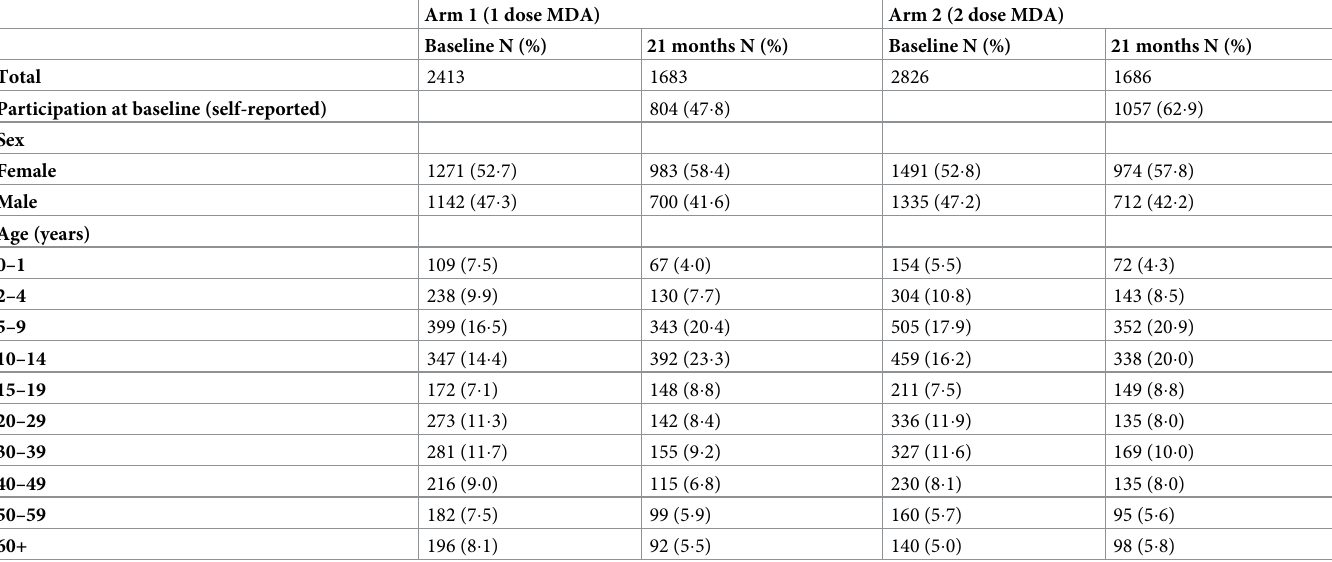
Table 1. Demographic characteristics of participants in the study at baseline and at 21 months.